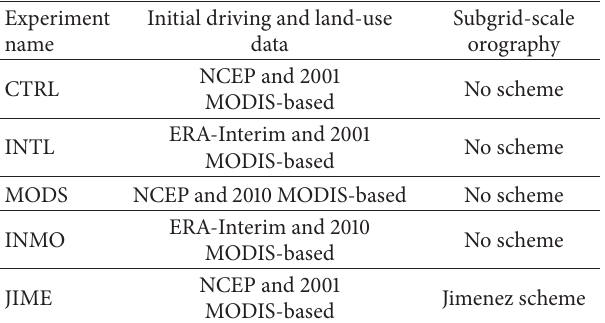
Table 1: Experiment